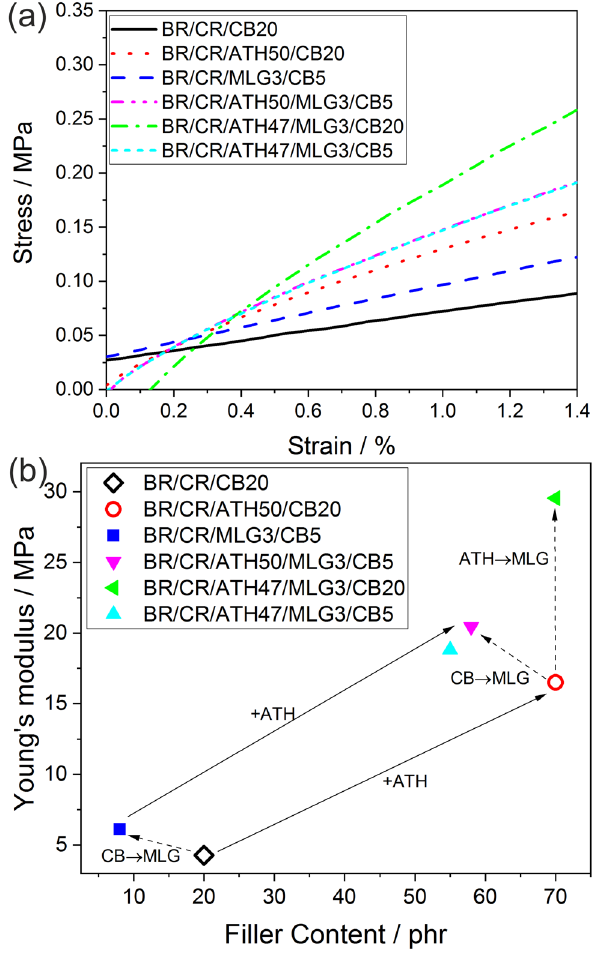
Figure 7: Tensile tests of cured BR/CR rubber composites; ( a ) stress – strain curve at low stresses, used to determine Young ’ s modulus and ( b ) Young ’ s modulus of the BR/CR composites vs fi ller